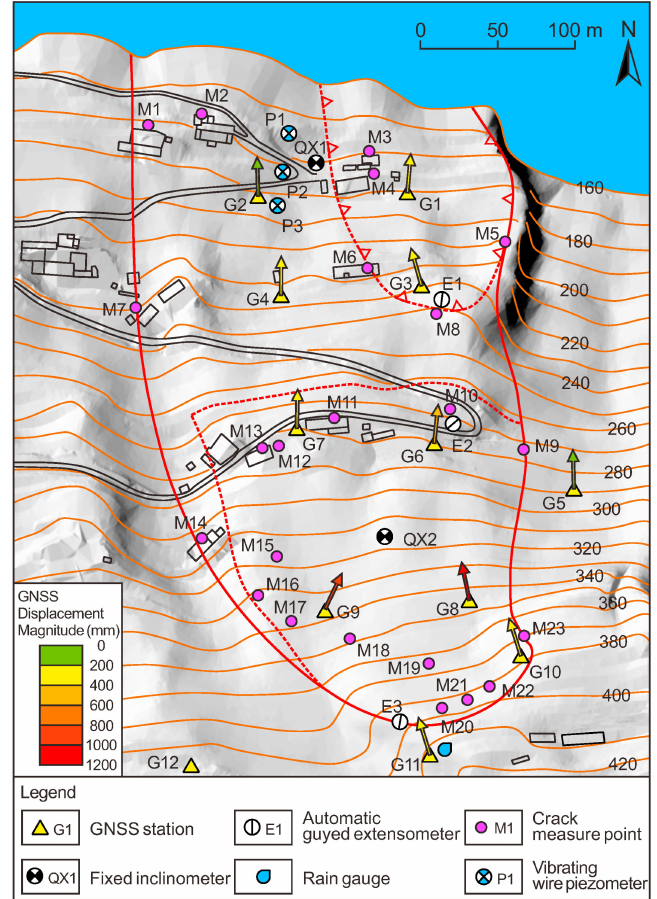
Figure 10. Layout of the real-time monitoring system. Arrows show the magnitudes and directions of the cumulative displacement obtained by global navigation satellite system (GNSS) receivers (data from 15 July 2015 to 7 March 2018).